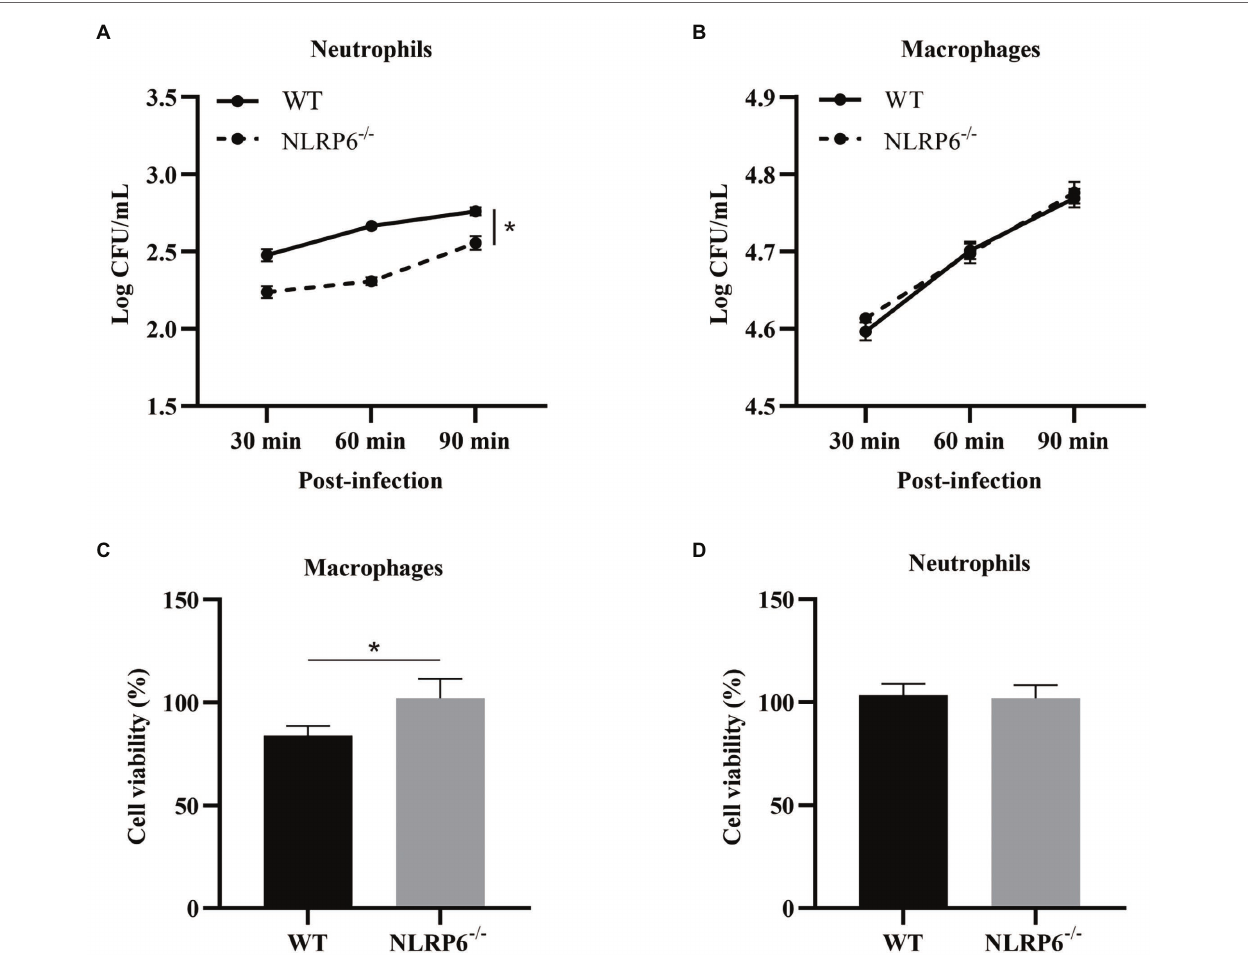
FIGURE 5 | NLRP6 deficiency enhances neutrophil intracellular bactericidal capacity and macrophage viability. Neutrophils and macrophages from WT and NLRP6 − / − mice. Neutrophils and macrophages were infected with S. pneumonia e (MOI = 10) and the intracellular bactericidal capacity of neutrophils (A) and macrophages (B) was measured at 30, 60, and 90 min by estimating intracellular CFU using 6 wells/group. The cell viability of macrophages (C) at 24 h and the cell viability of neutrophils (D) at 12 h after infection with S. pneumoniae (MOI = 1) were determined by WST-1 assay ( n = 3). Statistical significance was shown as * p <